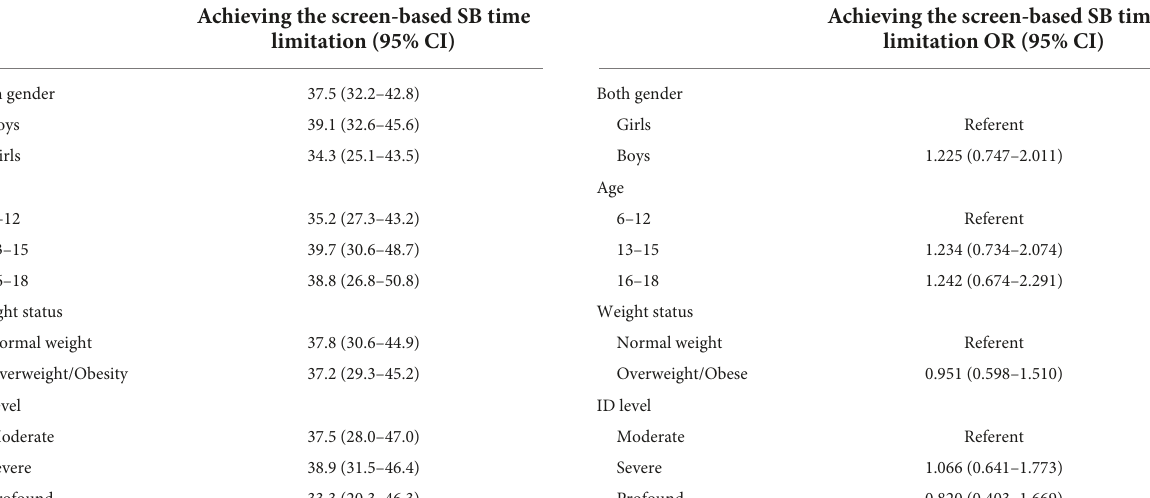
TABLE 3 Differences in prevalence of achieving the after-school screen-based SB time limitation among children and adolescents with ID by gender, age, weight status, and ID